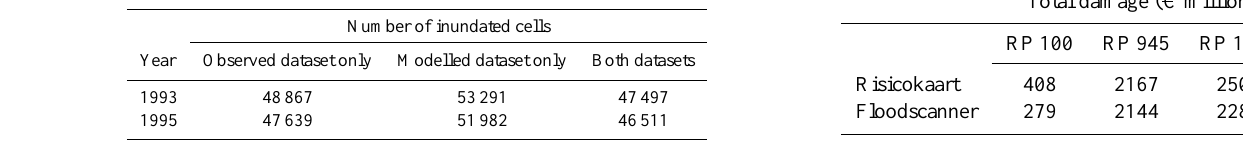
Table 2. Total damage simulated using Damagescanner with in- undation maps of Floodscanner and Risicokaart: for both sets of inundation maps the results are shown for three return periods (RP) (100, 945 and